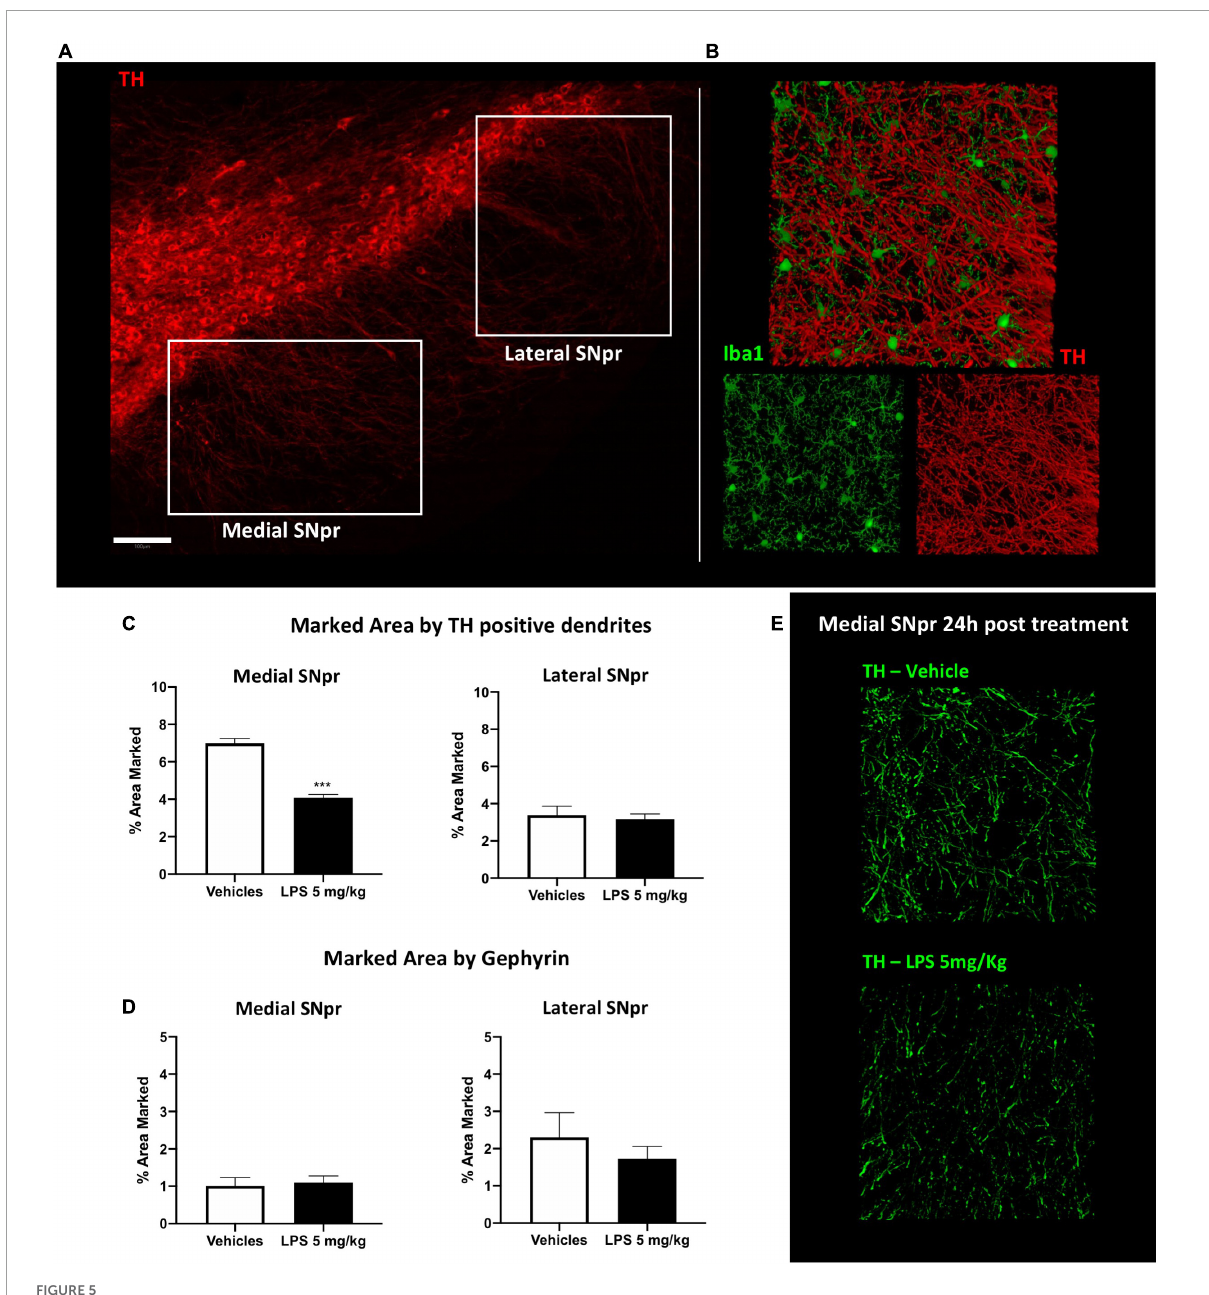
FIGURE5 Synaptic alteration in SNpr 24 h post LPS administration. (A) Qualitative images of TH + neurons in SNpc and their dendrites in SNpr. Scale bar = 100 um. (B) Qualitative confocal images of TH + dendrites (red) and microglial cells in SNpr (green). (C) Percentage of the marked area by TH + dendrites in medial and lateral SNpr 24 h after 5 mg/kg LPS or vehicle administration. Medial SNpr: Unpaired t -test F Treatment 2.250, p < 0.0007. Lateral SNpr: Unpaired t -test F Treatment 2.842, p < 0.7245. Significance: (***) respect relative vehicles. (D) Percentage of the marked area by Gephyrin in medial and lateral SNpr 24 h after 5 mg/kg LPS or vehicle administration. Medial SNpr: Unpaired t-test F Treatment 1.469, p < 0.7793. Lateral SNpr: Unpaired t -test F Treatment 4.027, p < 0.4810. (E) Confocal images of TH + dendrites in medial SNpr 24 h after treatment vehicle and LPS treated